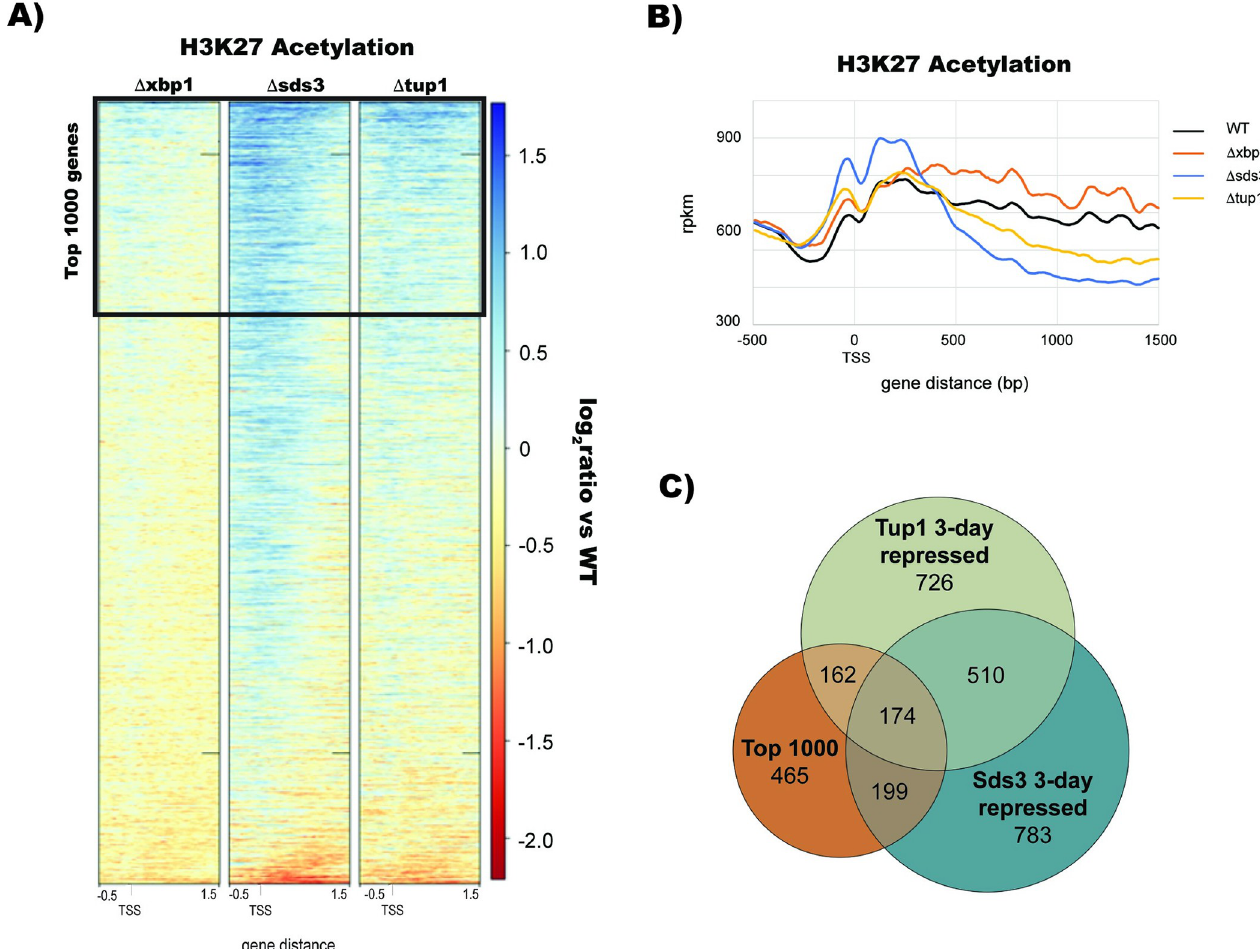
Fig 4. Tup1, Sds3, and Xbp1 are Required for H3K23 Deacetylation at Repressed Genes. (A) Heatmap showing the change in H3K23ac levels in deletion mutants compared to wild-type across all yeast genes. (B) H3K23ac profile levels across gene promoters, integrated across all yeast genes. (C) Venn diagram comparing the 1000 genes with the largest change in H3K23ac to genes repressed by Tup1 and Sds3 in stationary phase.